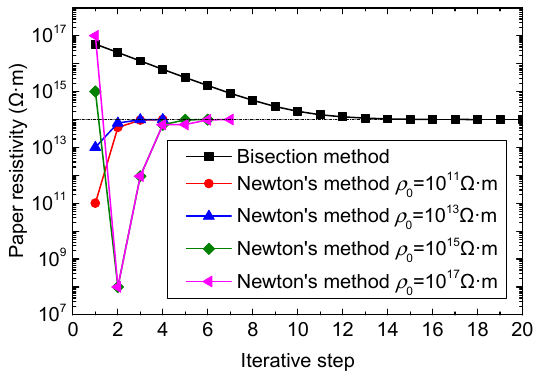
Figure 10. Calculation results using different iterative method.